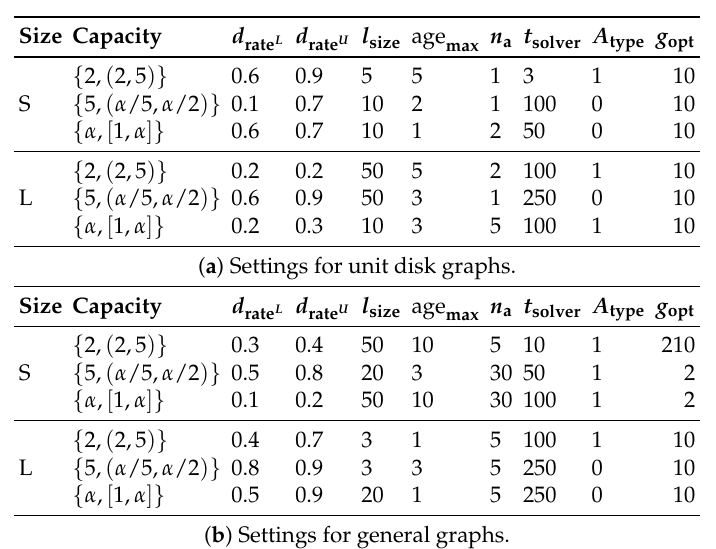
Table 1. C MSA ++ parameter values generated by irace for the instances from the literature.